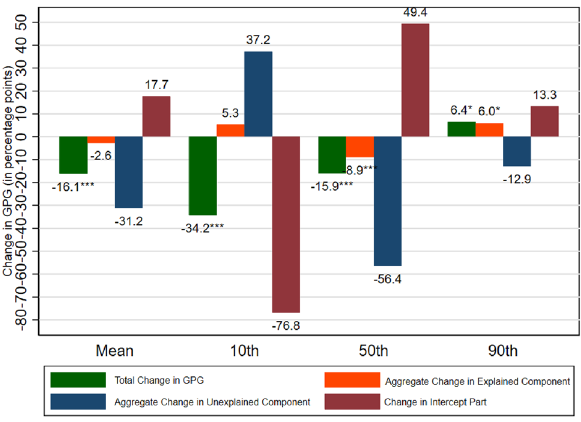
Fig. 3 Aggregate double decomposition of the change in the gender pay gap (GPG) 2020‑1984 across the distribution, female reference category. Figure shows detailed double decomposition of changes in the gender pay gap (GPG) in West Germany